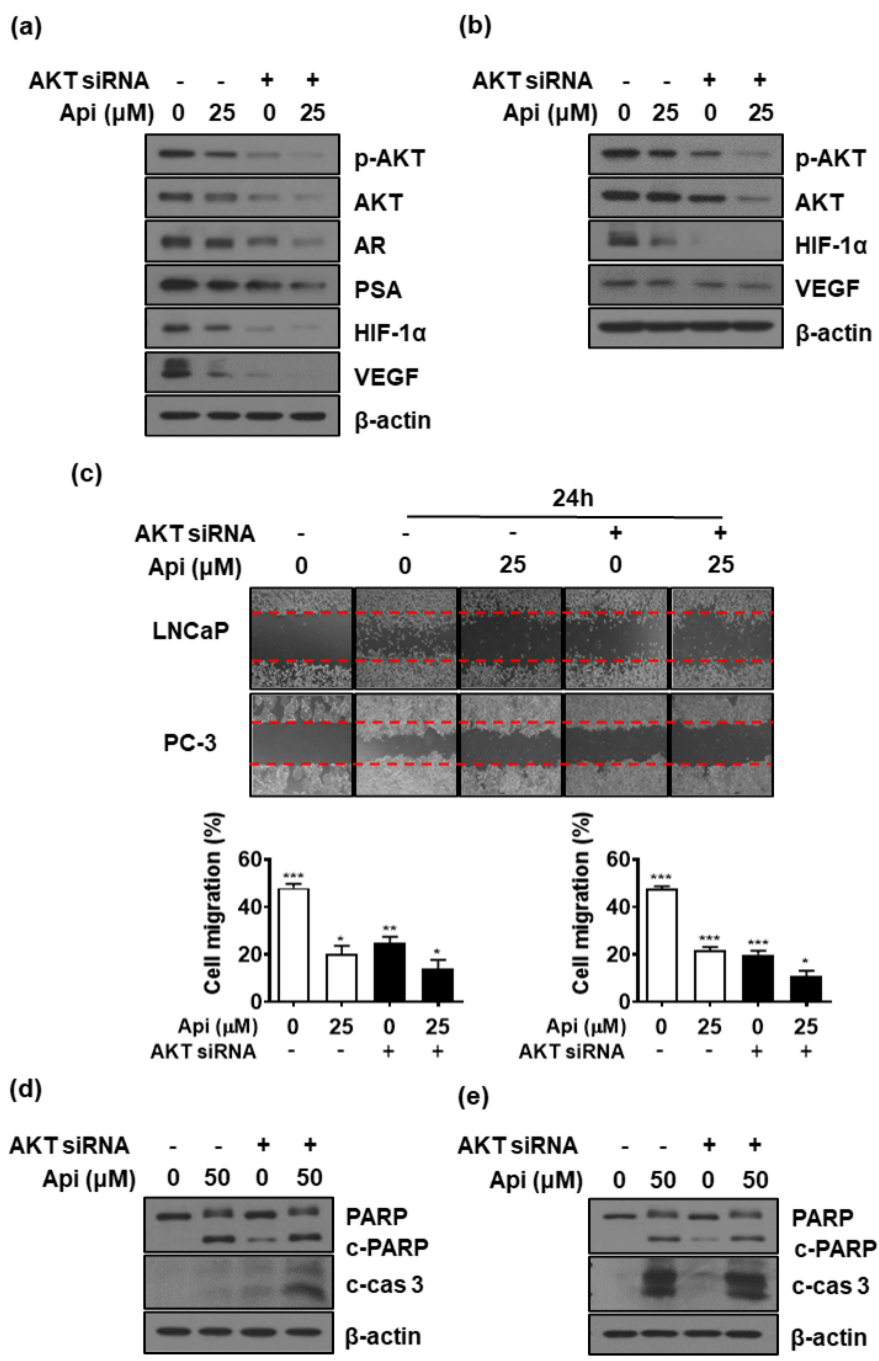
Figure 6. Effect of AKT siRNA in apigetrin-treated LNCaP and PC-3 cells. LNCaP ( a ) and PC-3 cells ( b ) were transfected with AKT siRNA for 48 h and were incubated in the presence or absence of apigetrin for 24 h. Cell lysates were prepared and subjected to western blotting to analyze the expression of AKT, p-AKT, AR, PSA, HIF-1 α , VEGF, and β -actin. ( c ) LNCaP and PC-3 cells were transfected with AKT siRNA for 24 h and were incubated in the presence or absence of apigetrin for 24 h. Cell migration was performed using wound-healing assay. Bar graph represents the quantification of cell migration, presented as percentage compared to the control * p < 0.05, ** p < 0.01, and *** p < 0.001. LNCaP ( d ) and PC-3 cells ( e ) were transfected with AKT siRNA for 48 h and were incubated in the presence or absence apigetrin for 48 h. Cell lysates were prepared and subjected to western blotting to determine PARP, cleaved-PARP, cleaved-caspase-3, and β